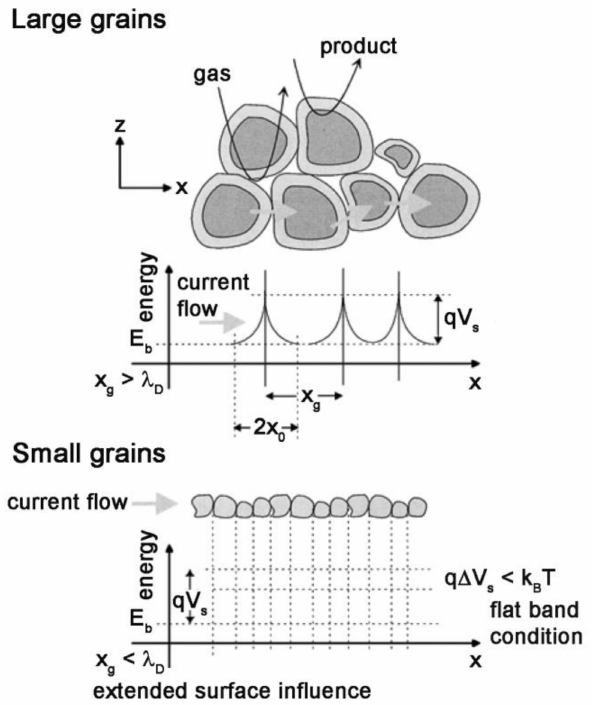
Figure 4. Schematic representation of a porous film with different grain size and energy band. ( λ D : Debye length; x g : Grain size; x 0 : Depletion layer thickness) Reprinted with permission from reference